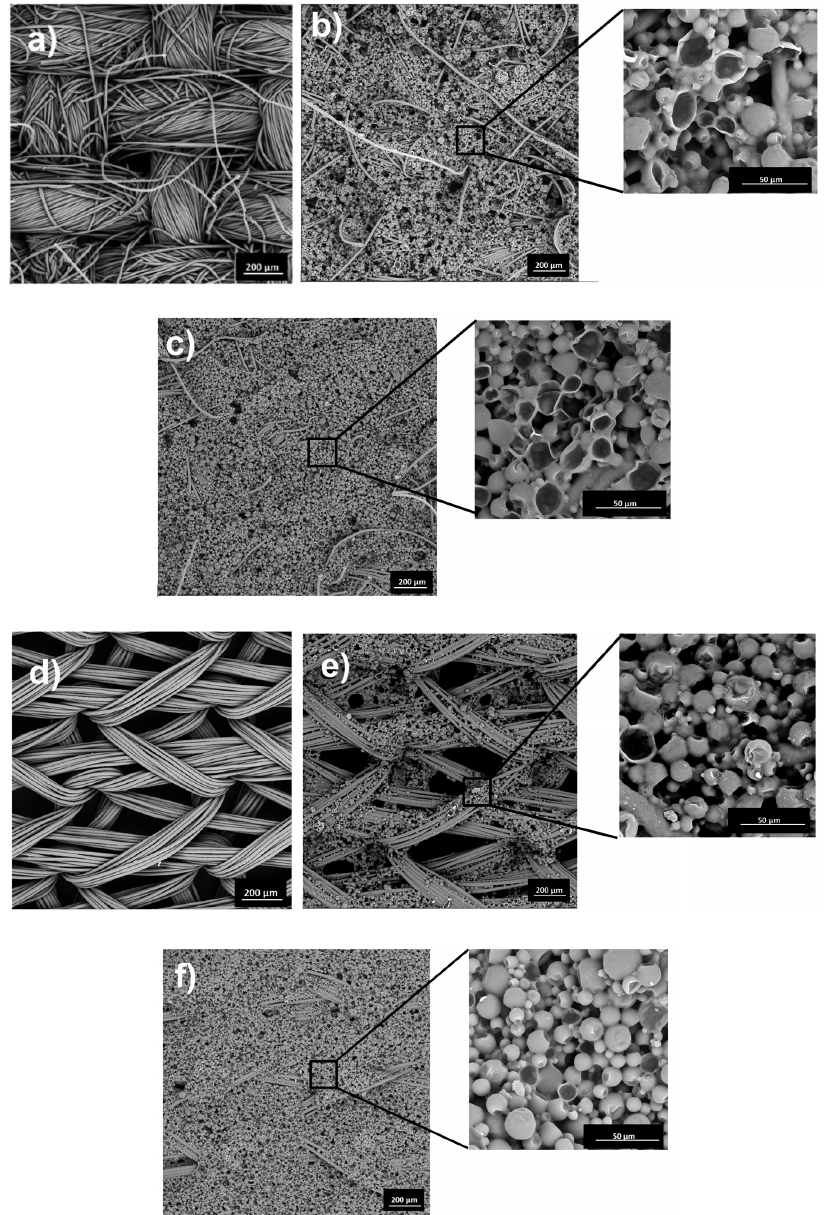
Figure 1. SEM images of the surface of: ( a ) raw and modified woven fabric (W): ( b ) W28 / 20, ( c ) W28 / 40 and ( d ) raw and modified knitted fabric (K): ( e ) K28 / 20, ( f ) K28 / 40 (magnification 150×, 1000×).